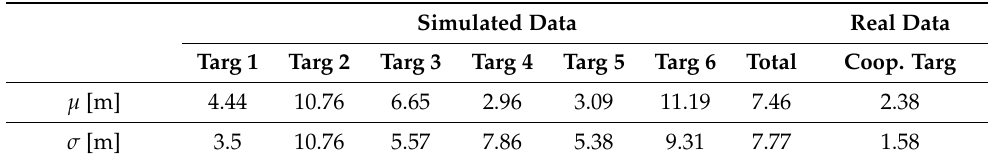
Table 1. Location error statistics for simulated and real GPS based PR